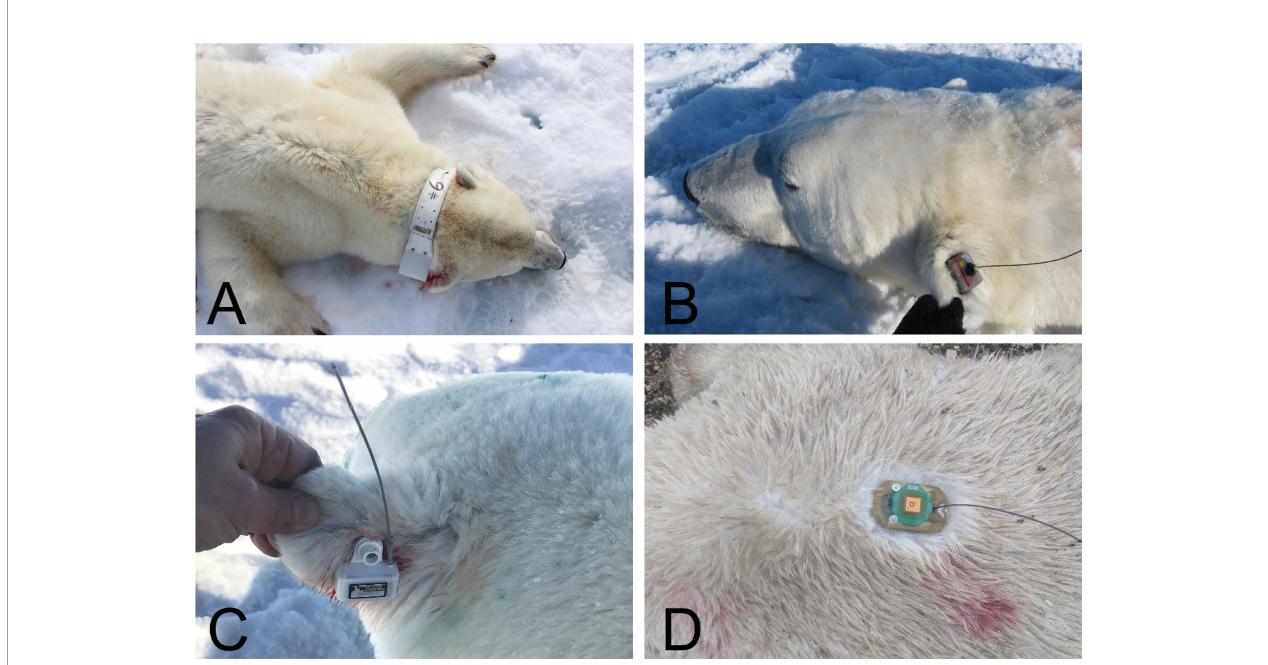
FIGURE 1 | Different types of satellite tags (ST) on polar bears: (A) : ARGOS Satellite collar (Telonics), (B) : Satellite ear-attached tag (Wildlife Computers, Redmond WA), (C) : Satellite ear-attached tag (Telonics), and (D) : Glue-on satellite tag (Wildlife Computers, Redmond WA). Collars have been the most robust and reliable way to collect multi-year data from polar bears. Photos by Kristin Laidre (A) , George Durner/USGS (C) and Karyn Rode/USFWS (B, D)